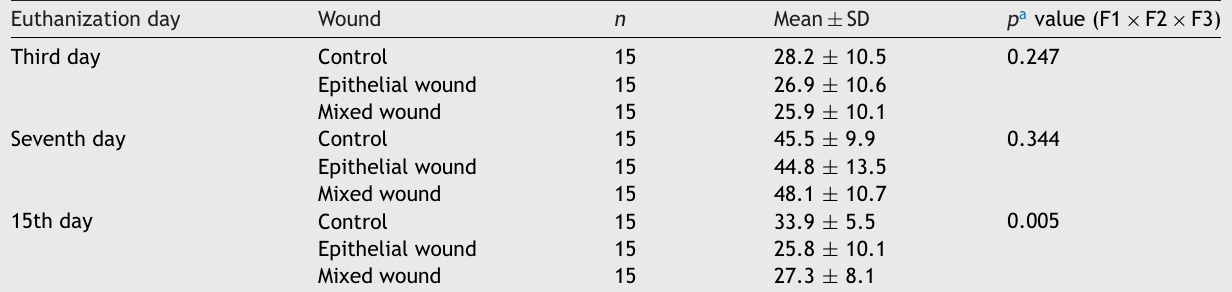
Macrophage count per field and comparison of wounds 1, 2, and 3 at each moment of euthanization. Euthanization day